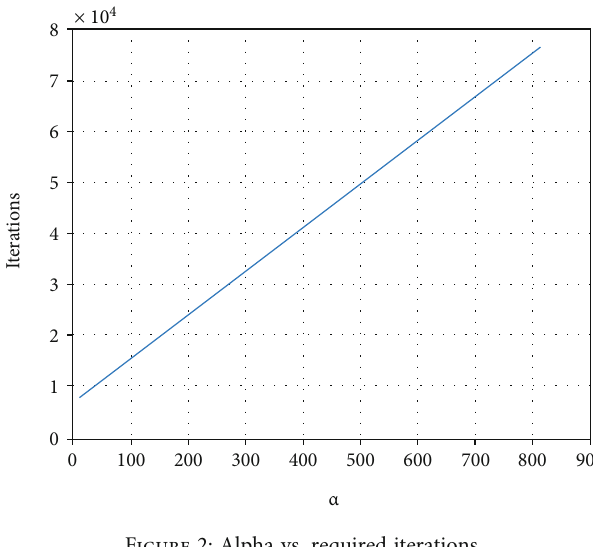
Figure 2: Alpha vs. required